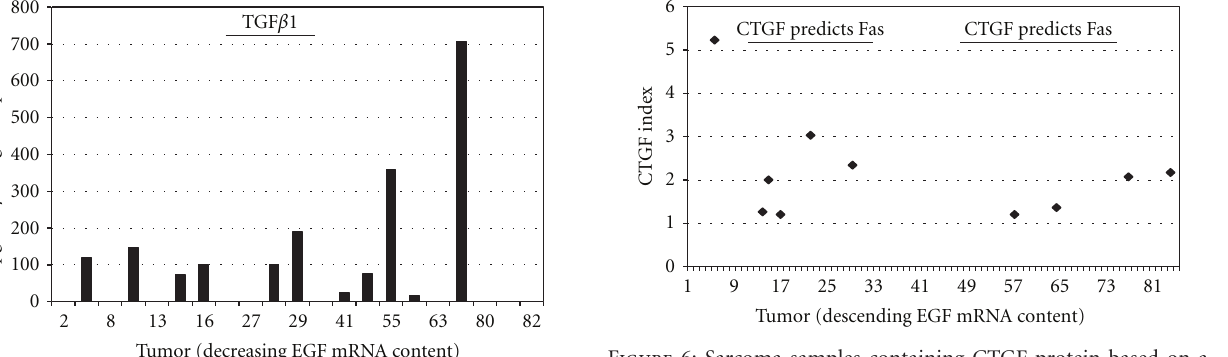
Figure 6: Sarcoma samples containing CTGF protein based on a dot blot analysis. The lines labeled “CTGF predicts Fas” overlay the tumors within which CTGF significantly predicted Fas mRNA content. Refer to Results and Discussion for derivation of CTGF